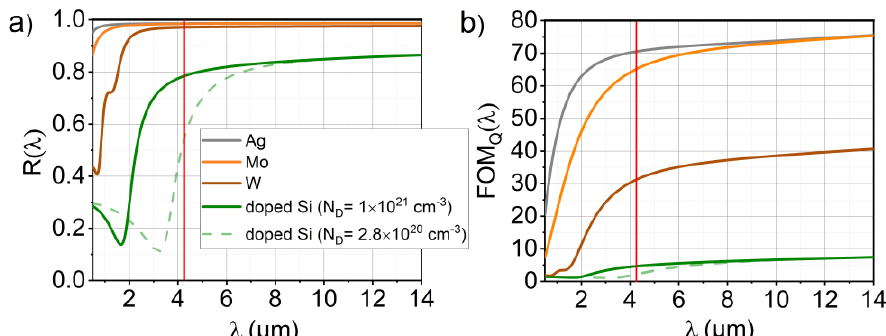
Figure 2. ( a ) Calculated reflectance and ( b ) figure of merit for the Q factor FOM Q in the mid-IR spectral region for different mirror materials based on the Lorentz–Drude models from the literature. The vertical red line indicates target resonance wavelengths λ 0 = 4.26 µ m. The doping concentration N D for the Si dispersion is denoted in the legend. The green dashed line shows the dispersion for the highest doping level currently achievable.